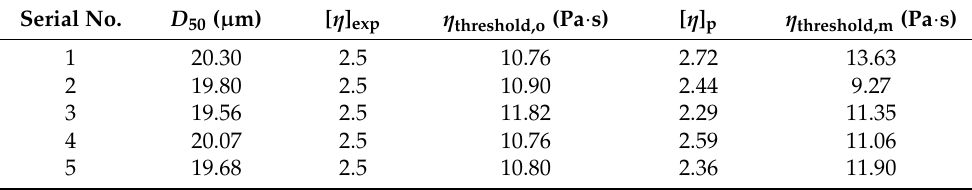
Table 3. The modified intrinsic viscosity [ η ] and plastic viscosity threshold. Serial